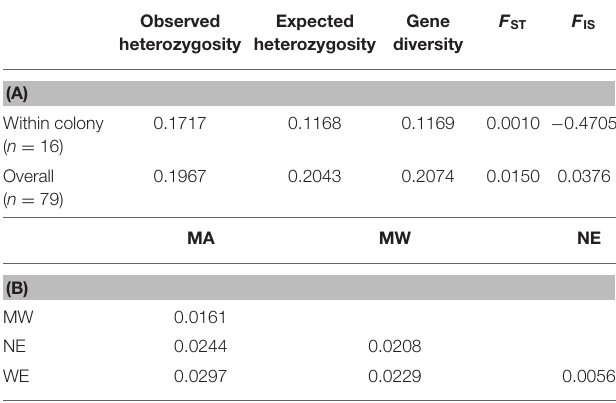
TABLE 1 | (A) Summary statistics of the Tetramorium immigrans SNPs data (B) pairwise F ST based on the four geographical regions (WE, Western; MA, Mid-Atlantic; MW, Midwest; NE, Northeast).